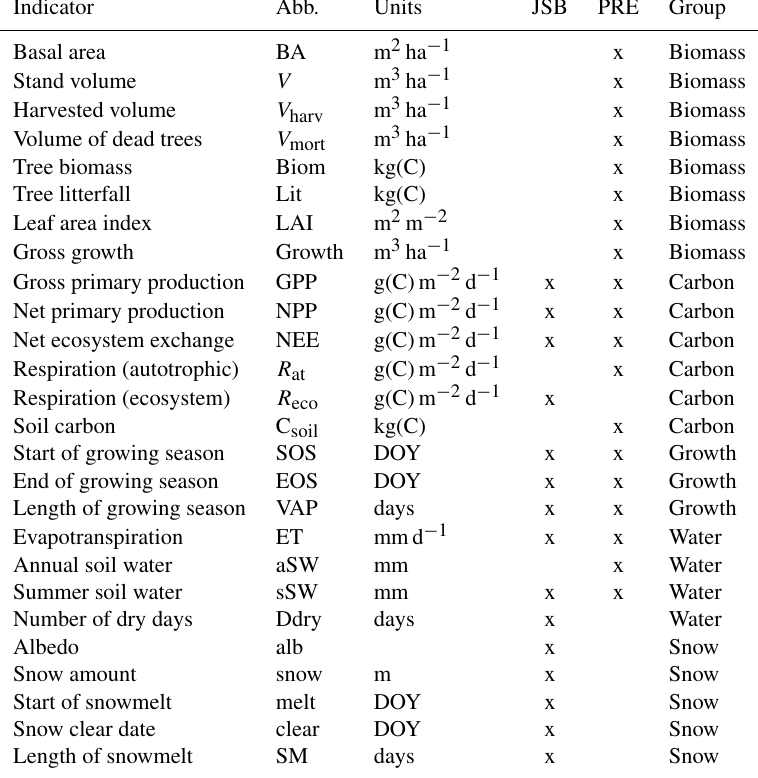
Table 2. Ecosystem indicators derived from the recorded values of the JSBACH and PREBAS simulations, separated into groups for the canonical correlation analysis. The group names relate to biomass distribution, ecosystem carbon exchange, length of the growing season, water cycle and snow melting